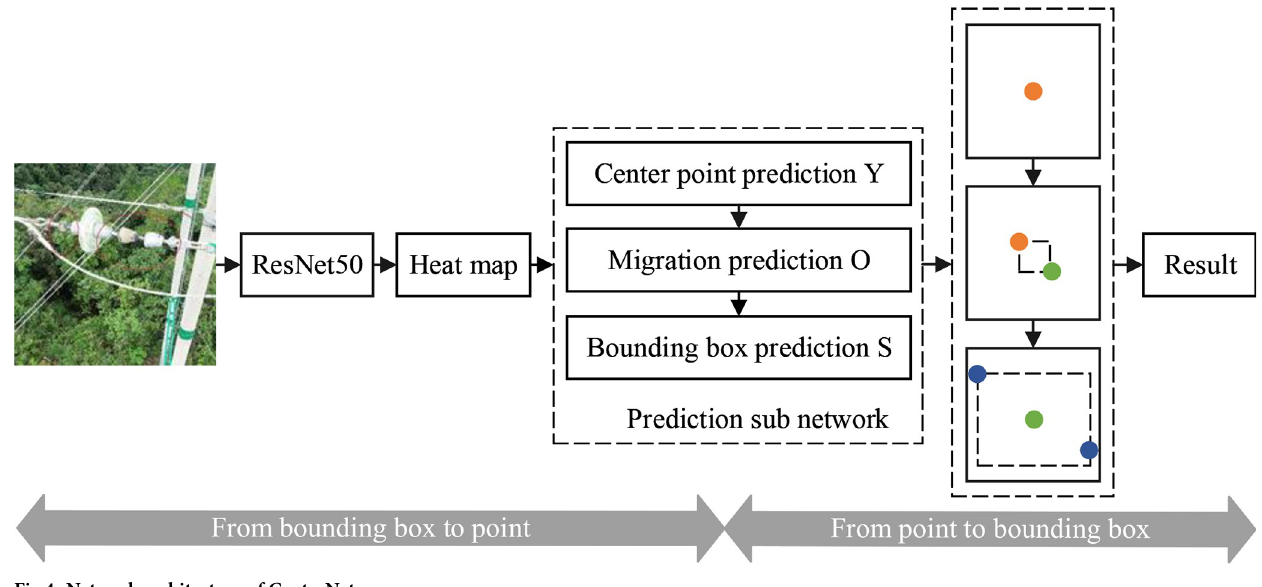
Fig 4. Network architecture of CenterNet.